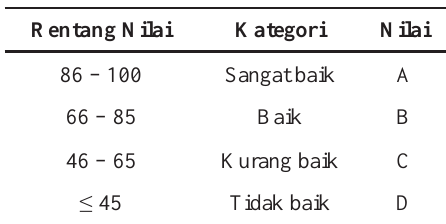
144 Strategi Pembelajaran Keterampilan ... (M. Fakhrur